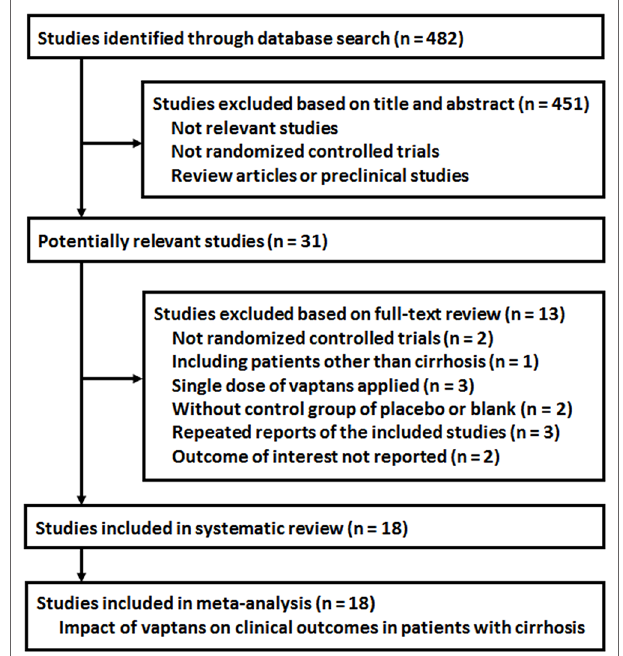
FIGURe 1 | Process of database search and study